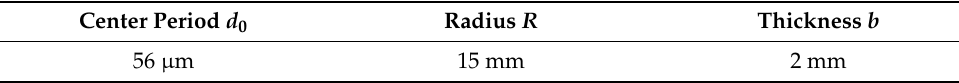
Table 2. The parameters of the aberrated off-axis Fresnel zone